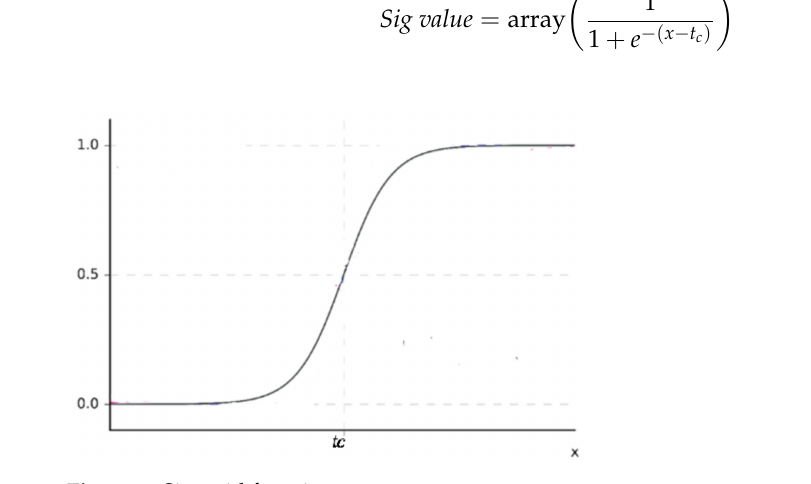
Figure 7. Sigmoid